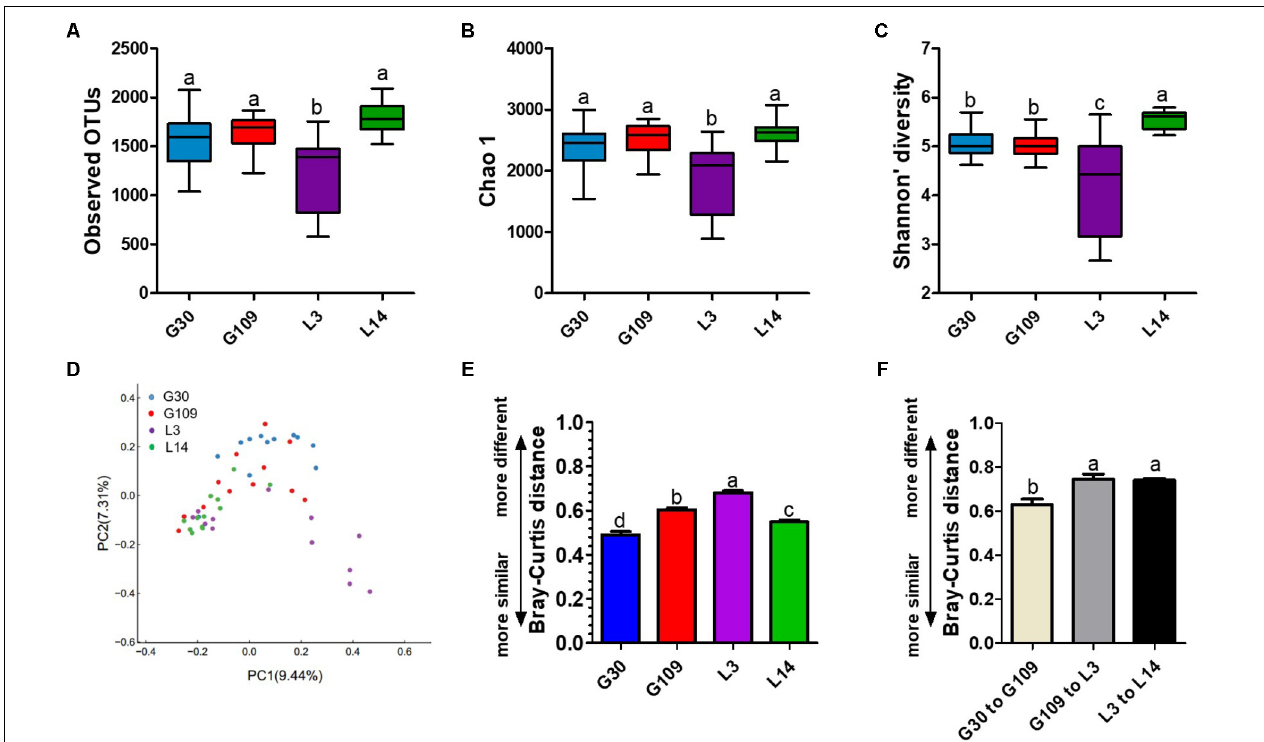
FIGURE 5 | The gut microbiota diversity of sows is significantly altered during pregnancy and lactation. (A) Comparisons of the number of observed OTUs among different reproductive stage sows. (B) Comparisons of bias-corrected Chao richness estimator (Chao 1) among different reproductive stage sows. (C) Comparisons of Shannon diversity indices among different reproductive stage sows. (D) Trajectory of the gut microbiota structure of sows across reproductive cycle based on Bray–Curtis distance. (E) Interindividual variations were determined by average Bray–Curtis distances between individuals in day 30 (G30) and 109 (G109) of gestation and day 3 (L3) and 14 (L14) of lactation, respectively. (F) Intraindividual variations were determined by distances between paired G30 and G109, G109 and L3, and L3 and L14 samples, respectively. Data are presented as means ± SEM ( n = 12). a–d, significant effect of sampling day ( P < 0.05; values with different lowercase letters are significantly different). G109, day 109 of gestation; L3, day 3 of